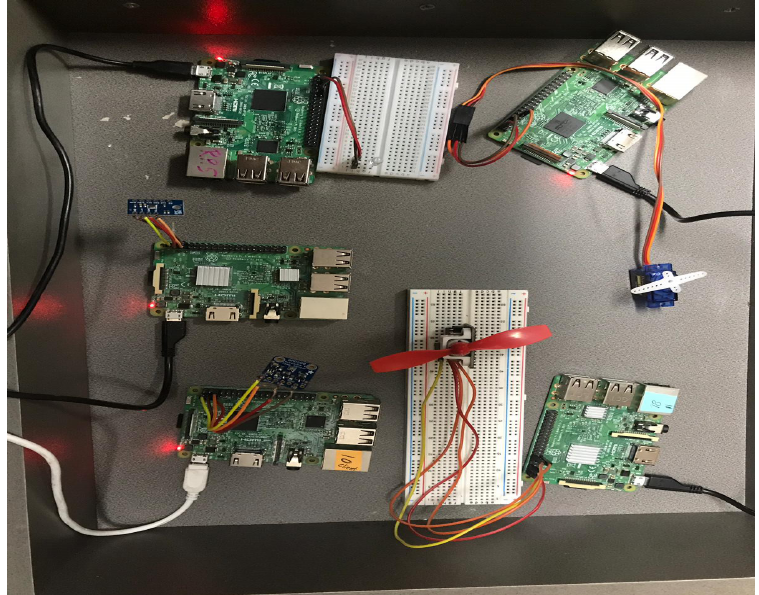
Figure 9. Physical IoT network in smart